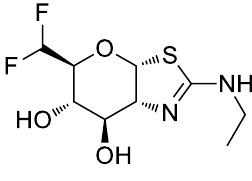
Figure 4. Structure of the O-GlcNAcase inhibitor MK-8719.